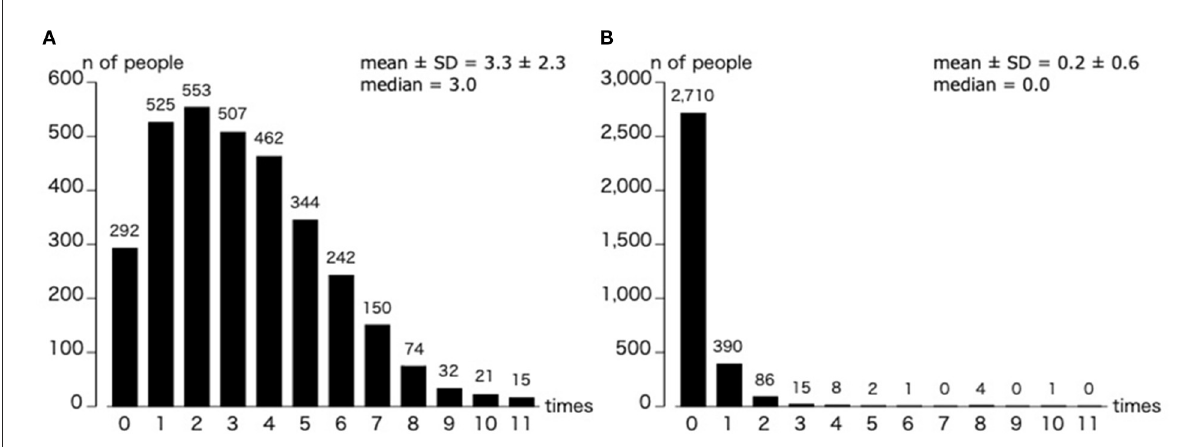
FIGURE3 Distribution of commission errors (A) and omission errors (B) in the differentiation experiment. The results were analysed using the data from 3rd grade of elementary school to 3rd grade of junior high school. n =